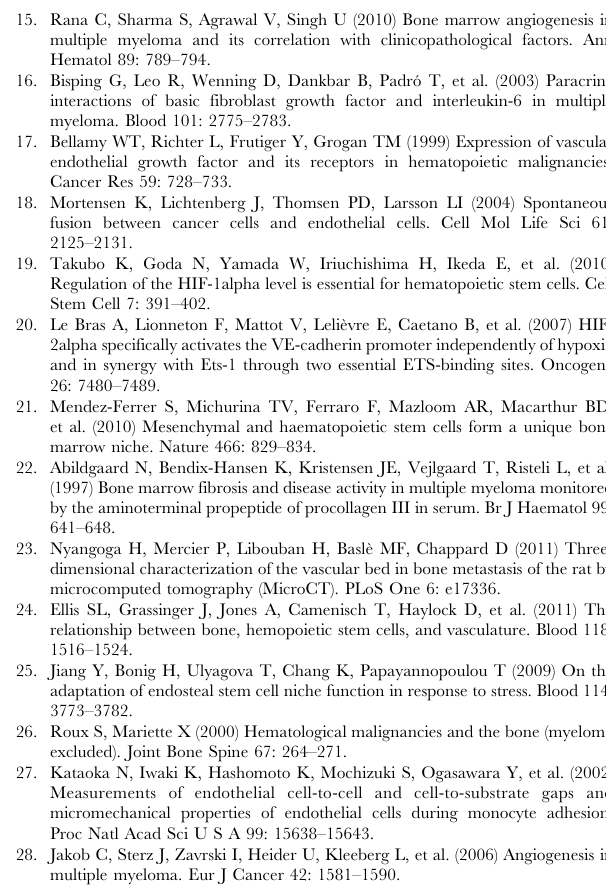
Table S1 U266-GFP cells rarely fused with